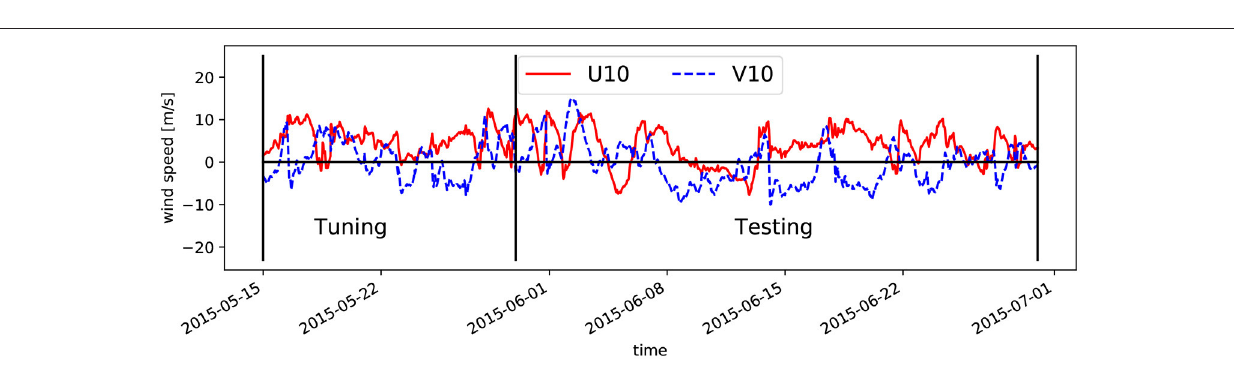
FIGURE 3 | Zonal and meridional wind speed components in 10 height near the island Helgoland. Respective 2D windmaps were used as metereological forcing for the considered circulation